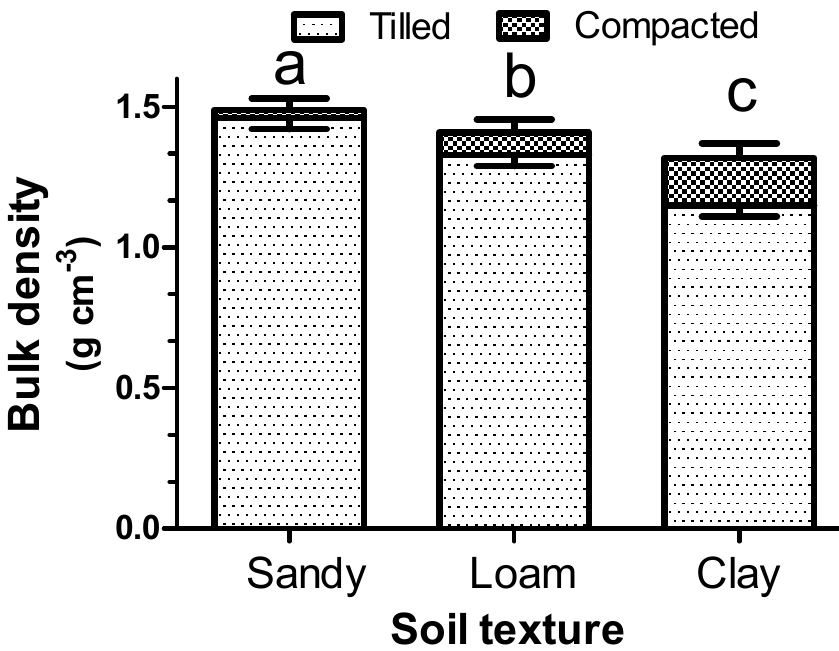
Figure 1. Bulk density (g · cm − 3 ) of the three different soil textures (sandy, loam, and clay) before (tilled) and after soil compaction. Different letters indicate the significance of the bulk density change (before/after soil compaction) to the Student–Newman–Keuls test ( p < 0.05). Vertical bars represent the standard error of the means.